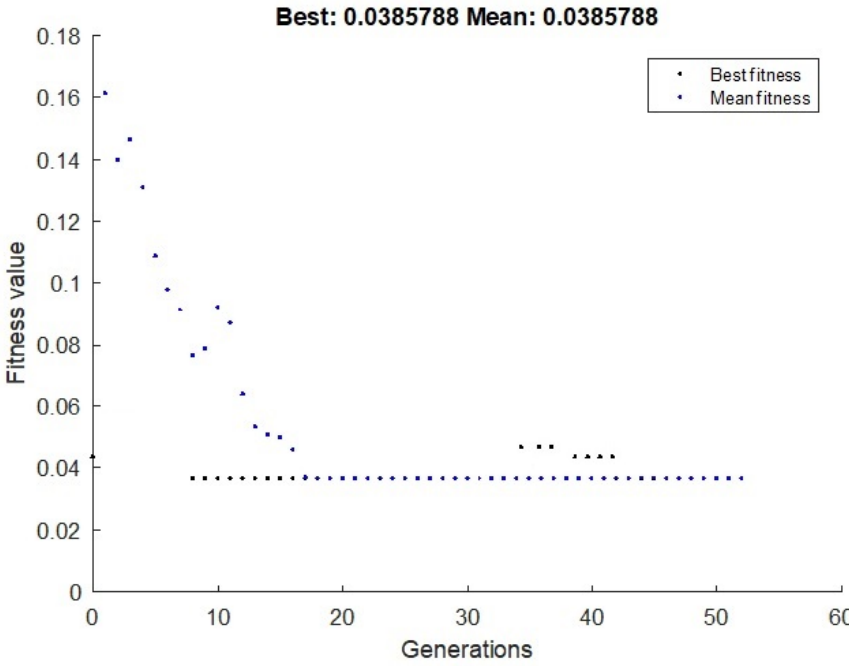
Figure 7. The convergence of the GA-ANN. Table 4. The minimum value for absolute relative clearance obtained using GA.